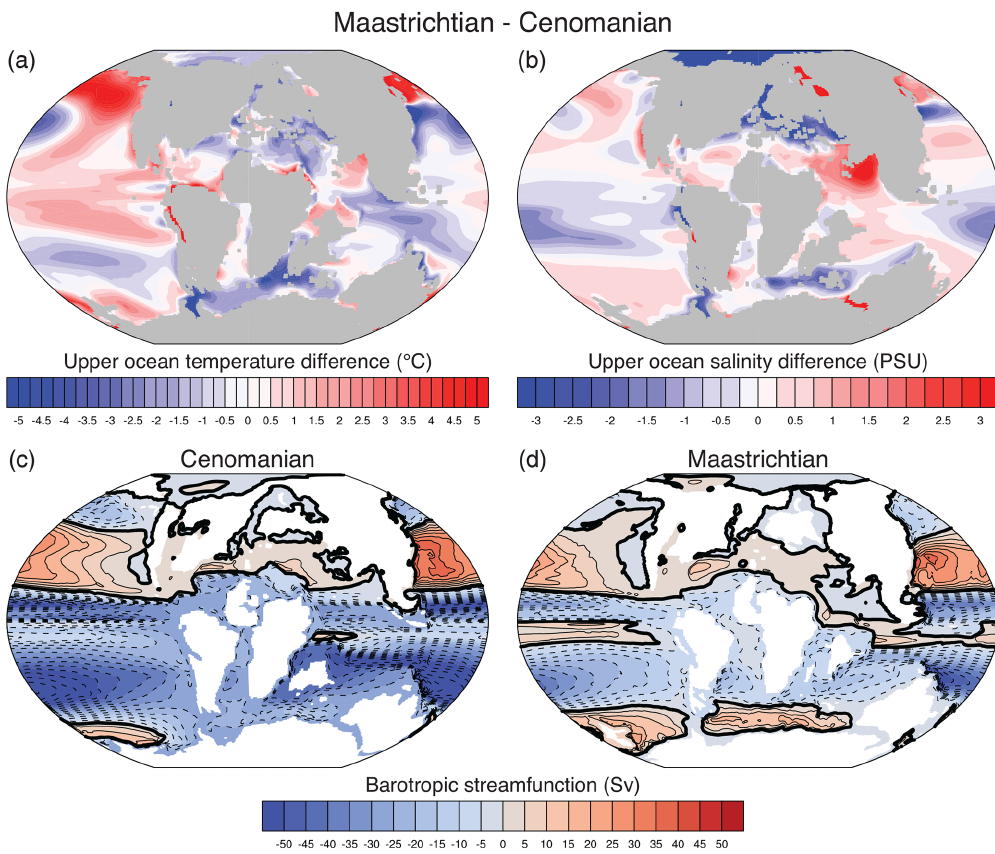
Figure 9. Climate diagnostics for the Maastrichtian simulation relative to the Cenomanian simulation. (a) Surface ocean (upper 100m) temperature difference ( ◦ C). (b) Surface ocean (upper 100m) salinity difference ( ◦ C). (c, d) Cenomanian and Maastrichtian barotropic streamfunction